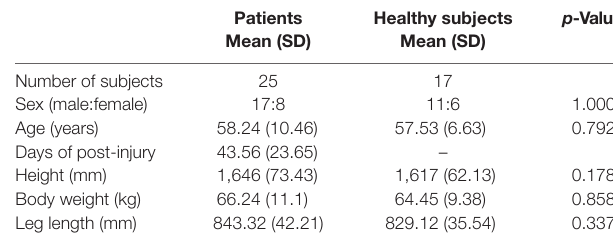
Table 1 | Anthropometric characteristics of the